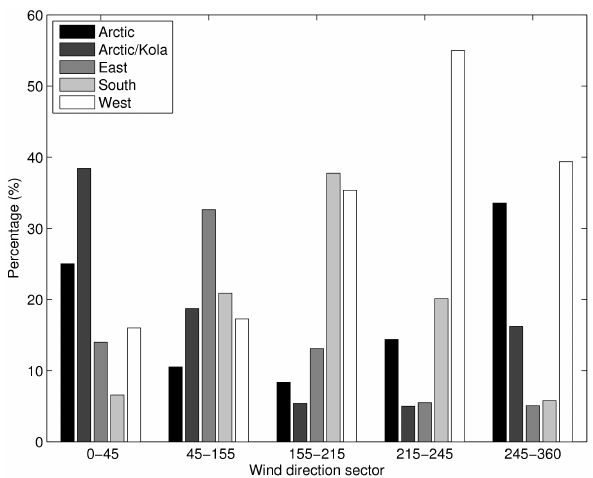
Fig. 9. 747 Fig. 9. The distribution of air mass origins (trajectory sectors) with each local source